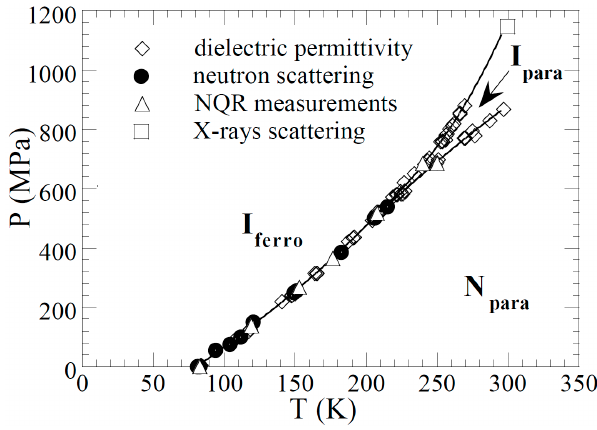
Figure 10. Phase diagram of TTF-CA.